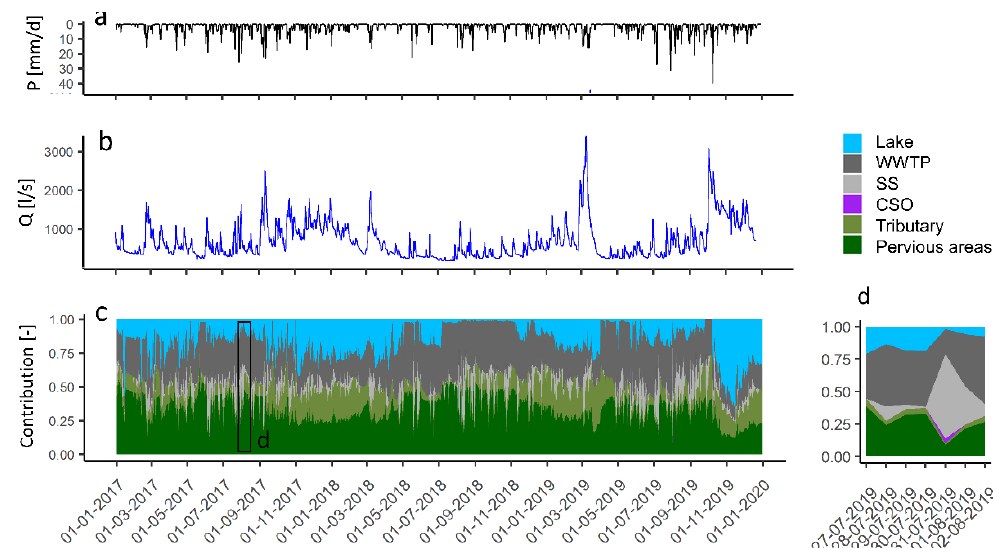
Figure 9. Simulations of the contribution of the different flow components at Nivemølle. ( a ) Measured precipitation in the model area; ( b ) Simulated flow in Usserød Stream, ( c ) Simulated flow contribution for the key features captured by the model; and ( d ) zoom to highlight a CSO event. The contribution is based on the sum of all inflows (lake (blue); flow from pervious areas (dark green); tributaries (light green); various urban features (WWTP: dark grey; SS: light gray)) and does not account for possible loss along the reaches. ( d ) Selected time period showing the contribution of a CSO event (purple shading).